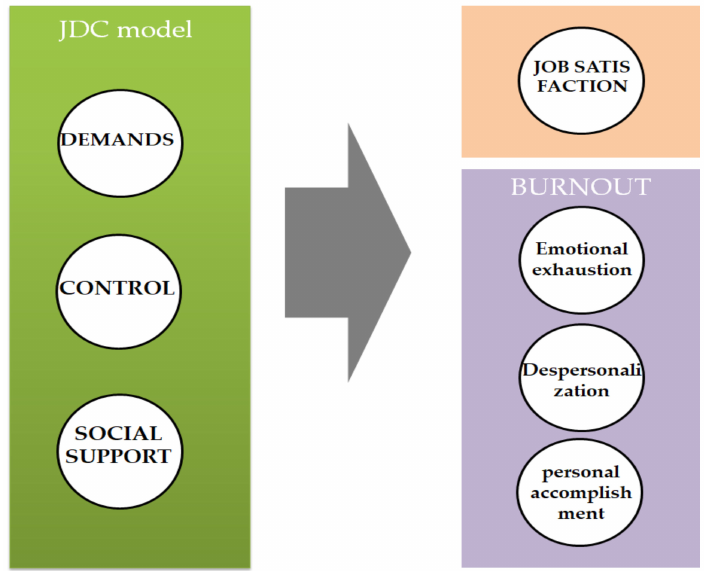
Figure 2. The proposed